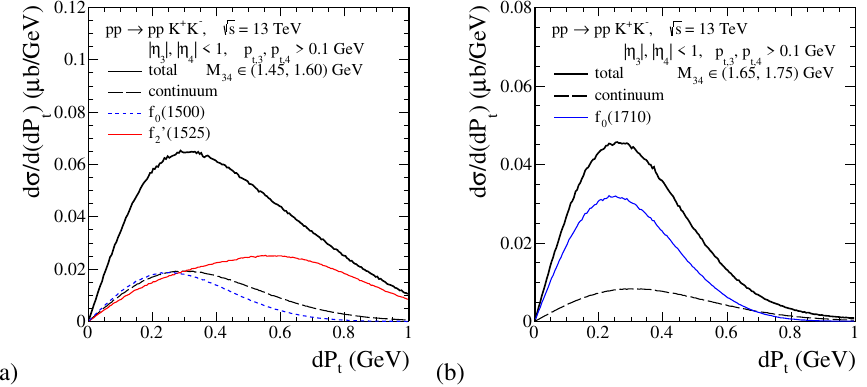
√ s = 13 TeV, | η K | < 1, p t , K > 0 . 1 GeV,